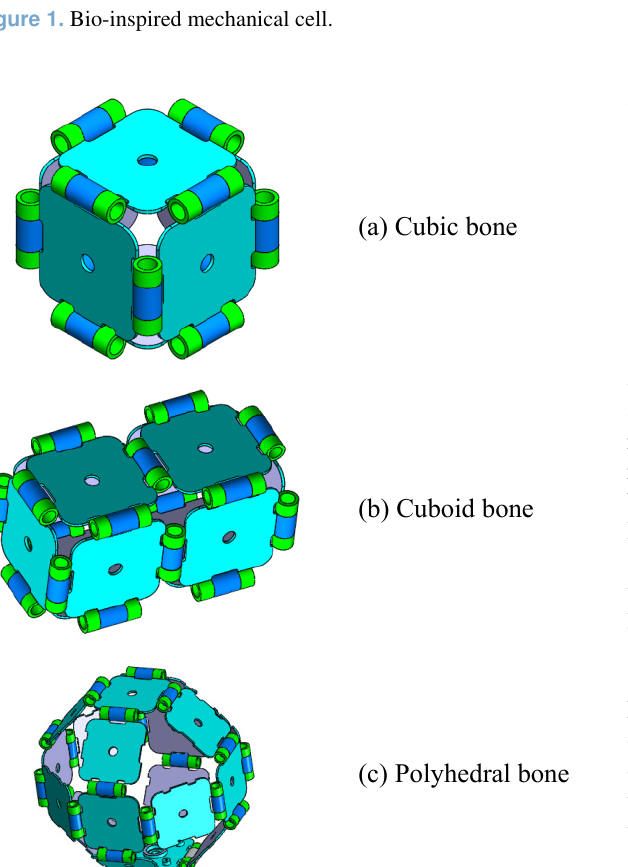
Figure 1. Bio-inspired mechanical cell.